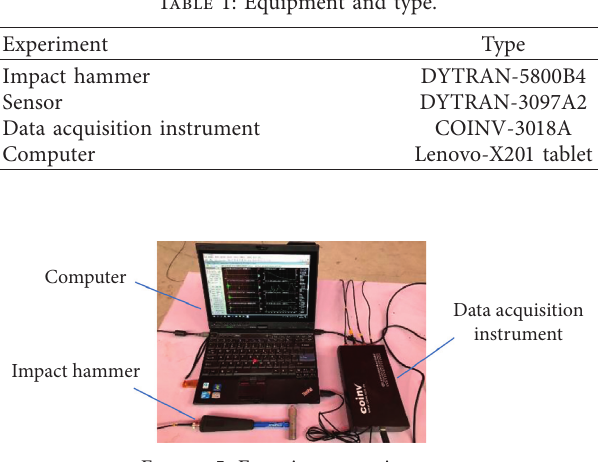
Figure 5: Experiment equipment.